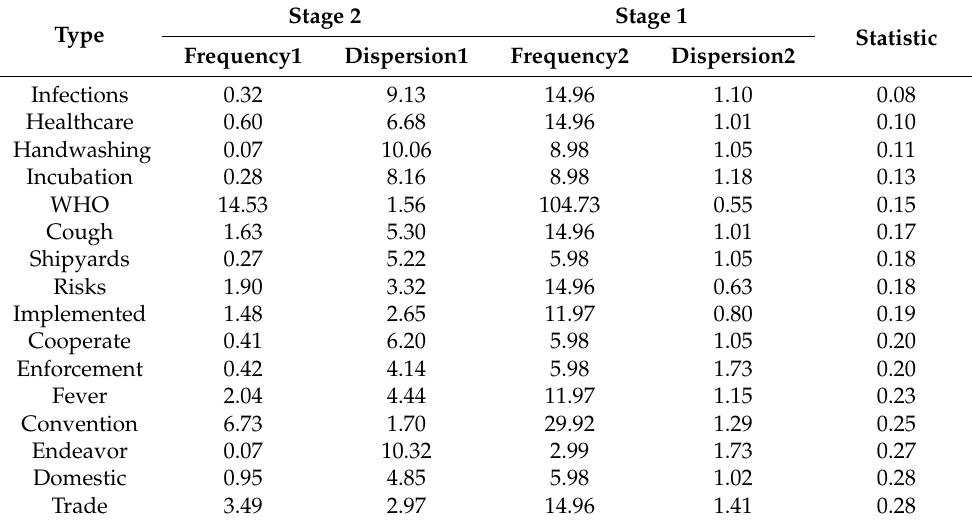
Table 3. Negative keywords for Stage 2 to Stage